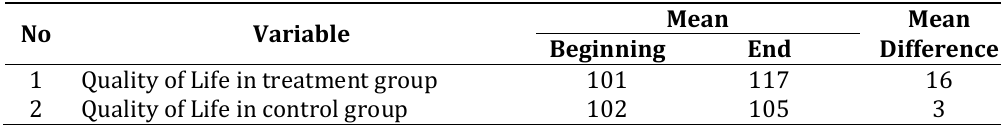
Differences in Quality of Life in the Treatment and Control